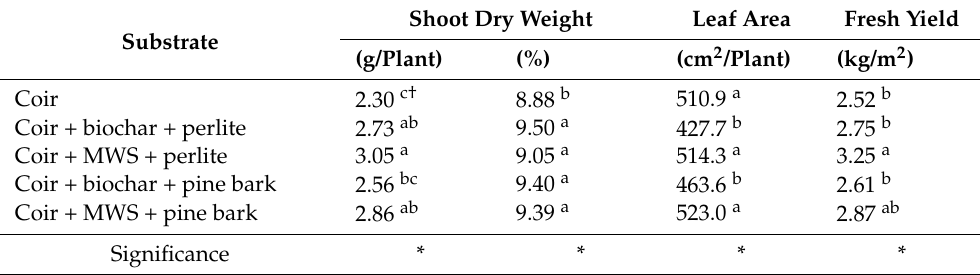
Table 5. Effects of substrates on shoot dry weight, leaf area, and fresh yield of spinach.